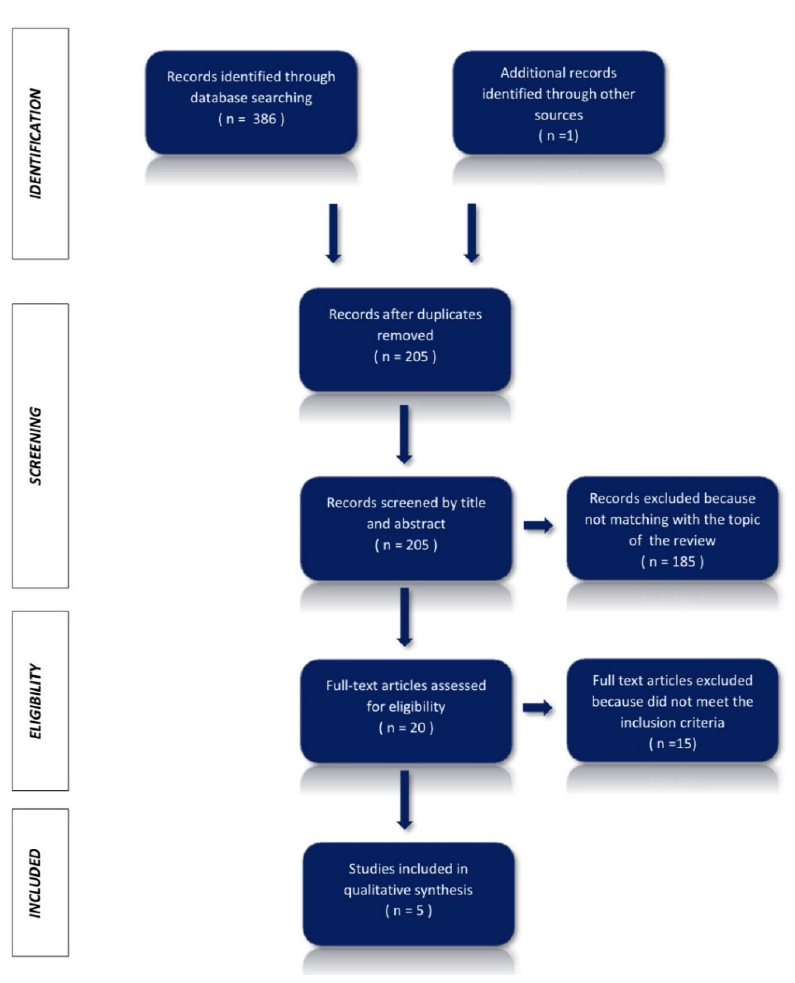
Int. J. Environ. Res. Public Health 2021 , 18 , x Figure 1. PRISMA (2020)—Flow Diagram. Figure 1. PRISMA (2020)—Flow Diagram.